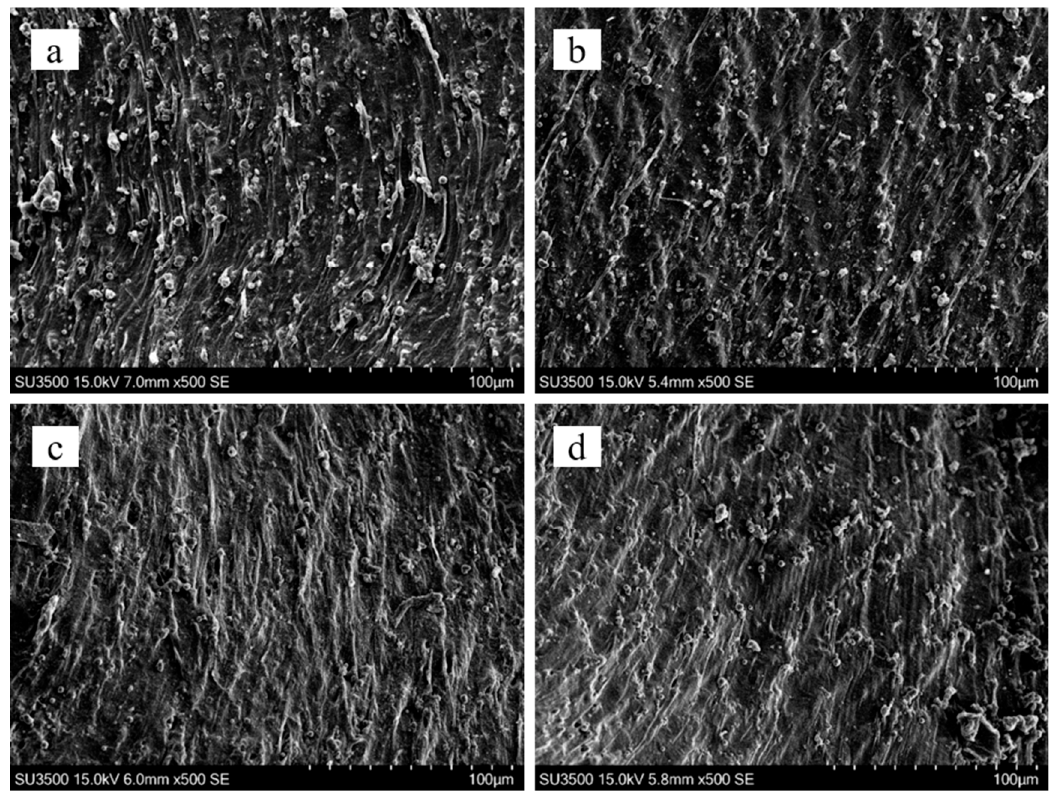
Figure 3. Microstructure of MRE and Si-MRE samples. ( a , c ) MRE for CV system and EV system respectively; ( b , d ) Si-MRE for the CV system and EV system, respectively.